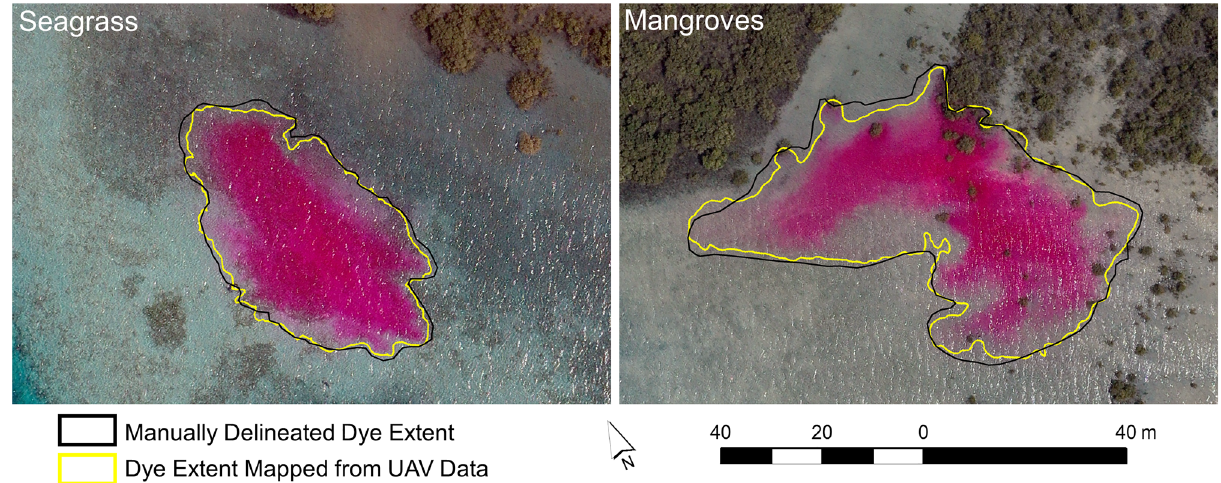
Figure 3. Maps of the dye plume extent. Comparison of dye plume extent mapped and manually delineated from the unmanned aerial vehicle data collected at 11:10 and 11:18 for the seagrass and mangrove release sites, respectively. Software used to produce the maps: eCognition Developer version 10.1.1 (https:// geosp atial. trimb le. com/ produ cts- and- solut ions/ ecogn ition) and ArcGIS version 10.5.1 (www. esri. com/ en- us/